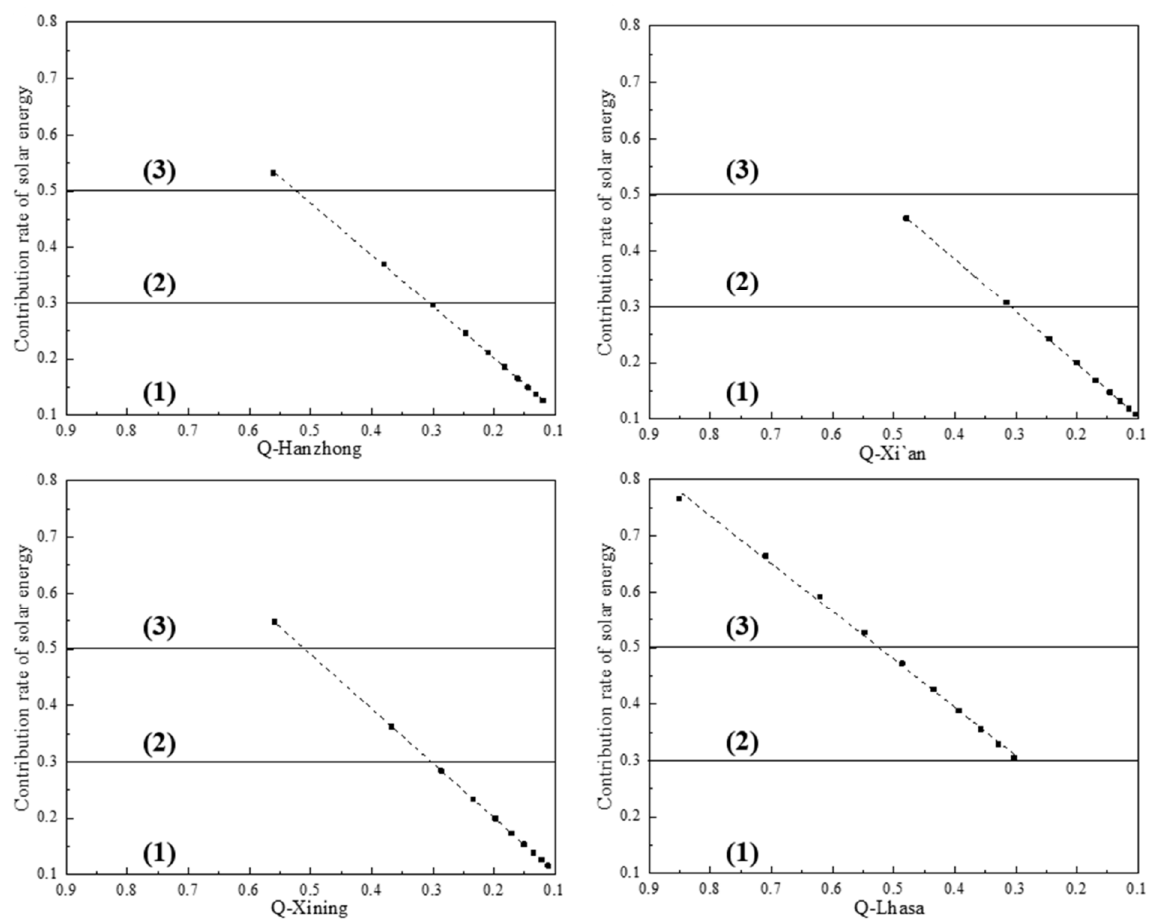
Figure 6. When Q is the independent variable, the solar energy contribution rate of three-star hotels in the four regions.